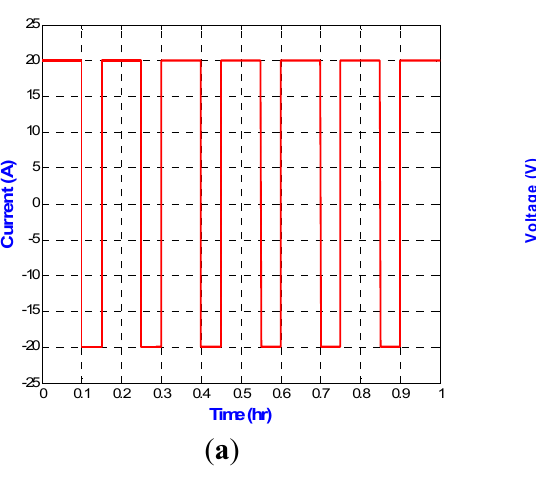
Figure 6. Identification test in experiment I. ( a ) Current profile; ( b ) Voltage profile; ( c ) SOC